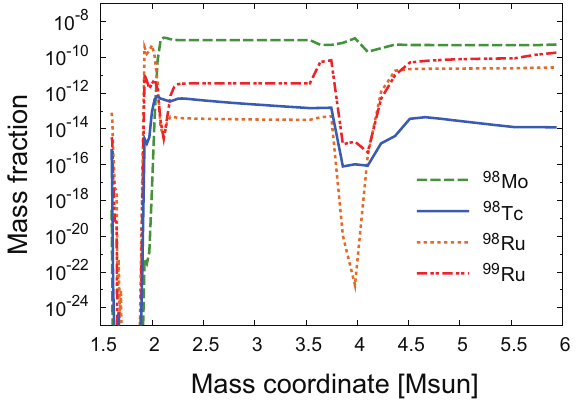
Figure 3. Calculated abundances. The solid line indicates the abundance of 98 Tc. The dashed, dotted, dashed double-dotted lines are 98 Mo, 98 Ru, and 99 Ru,